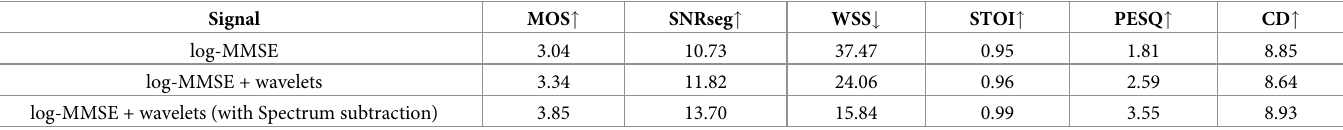
Table 2. Speech noise reduction ablation experiment table. Signal MOS " SNRseg "